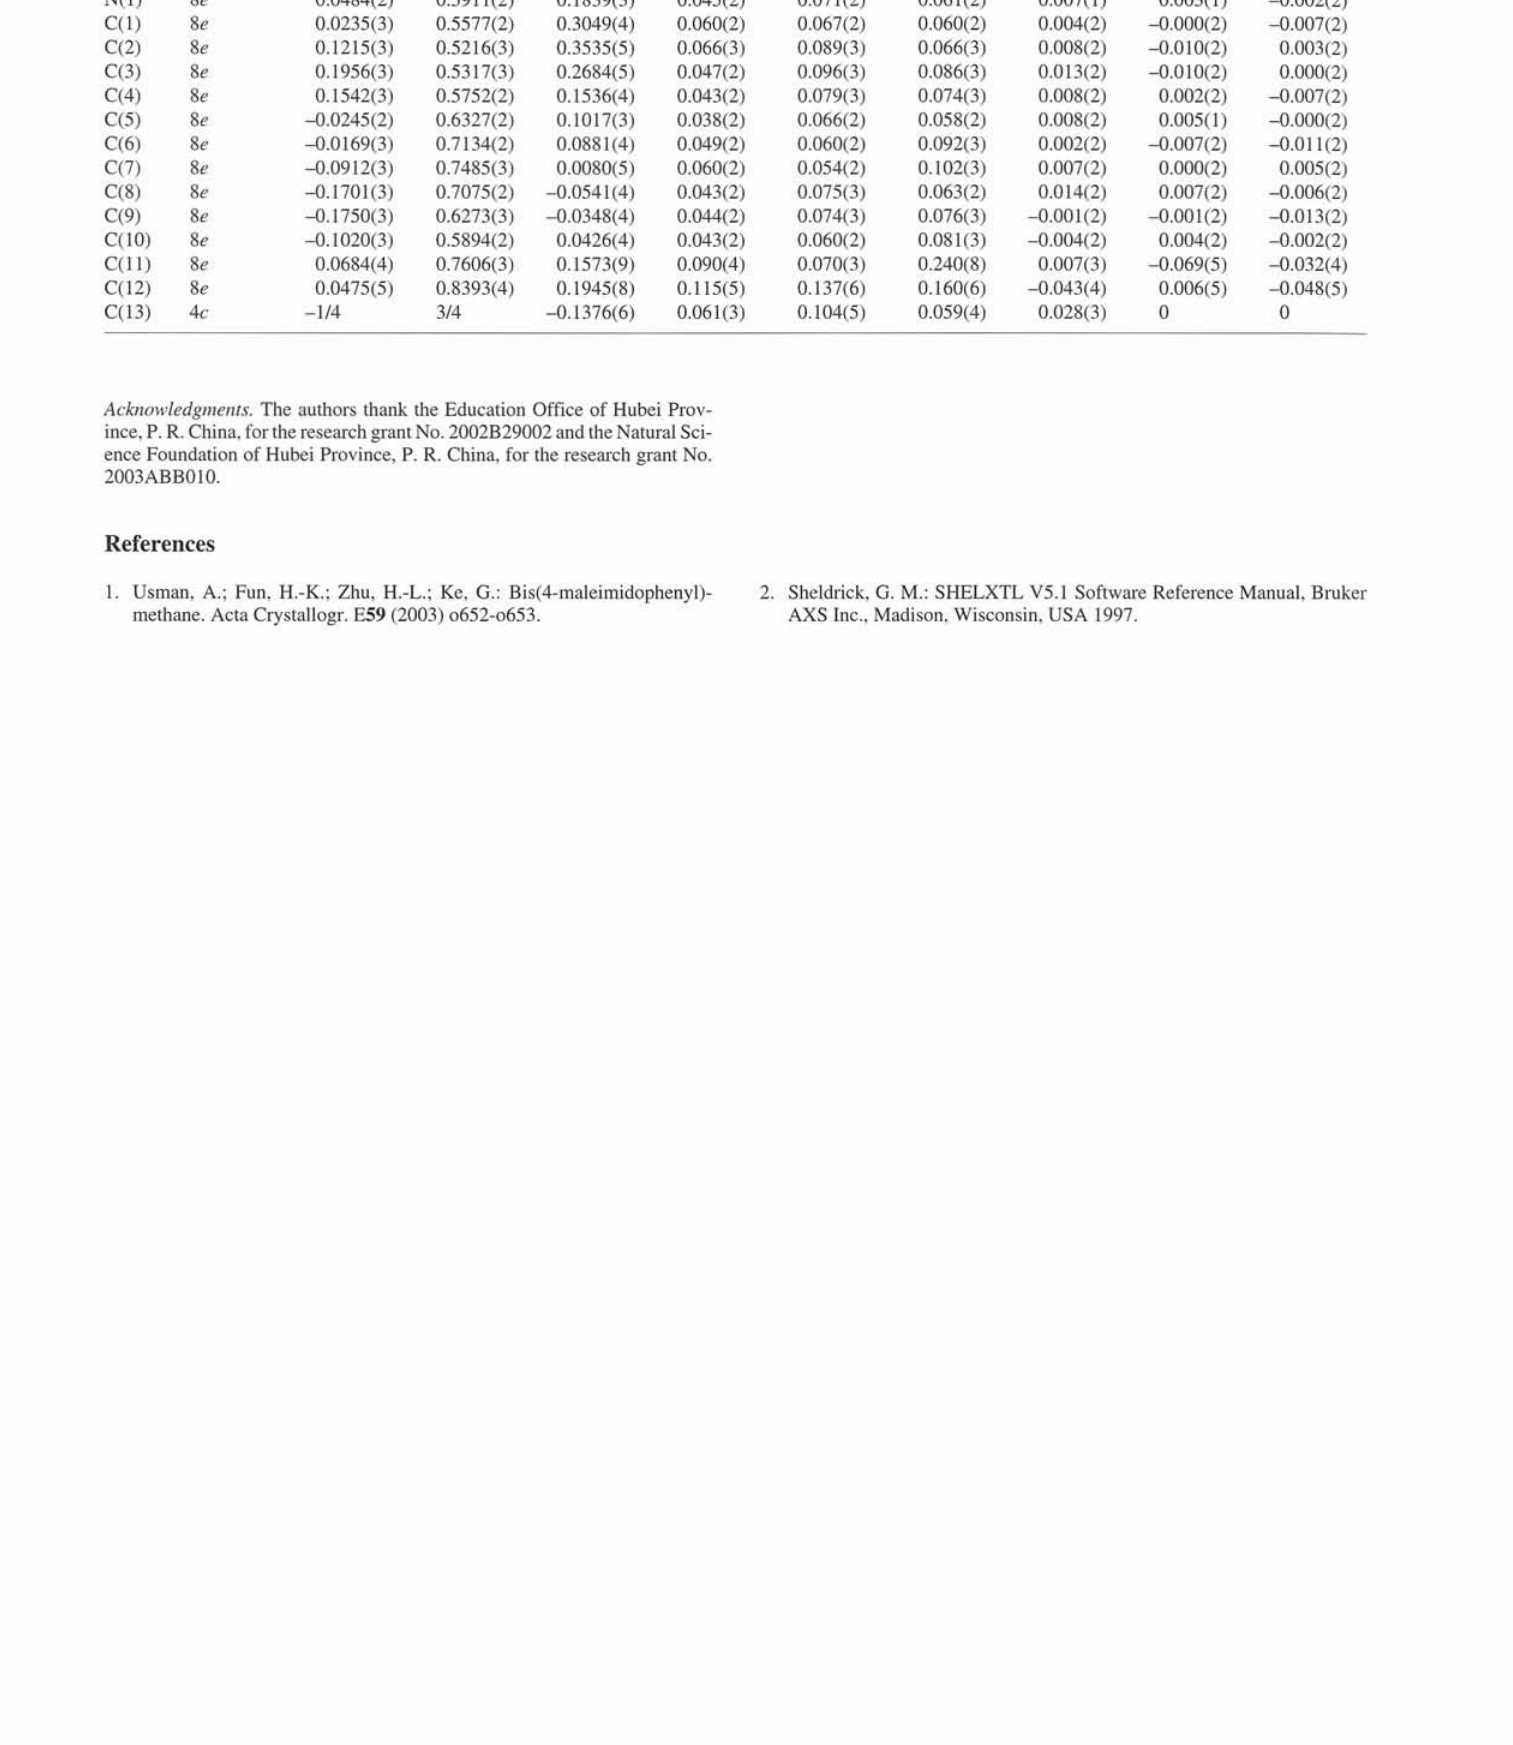
Table 3. Atomic coordinates and displacement parameters (in